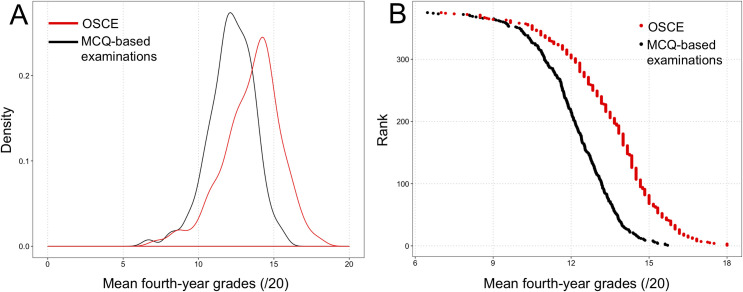
Distribution of mean OSCE grades (red) and mean fourth-year multiple-choice question (MCQ)-based grades (black). (A) Density plot showing the wider dispersion of OSCE grades compared to MCQ grades. (B) Relationship between student rank among the 379-student class, and grades obtained at OSCE and MCQ-based examinations, showing a flatter slope for OSCE and a steeper slope for MCQs, confirming the wider dispersion of OSCE grades than MCQ grades among the fourth-year class.